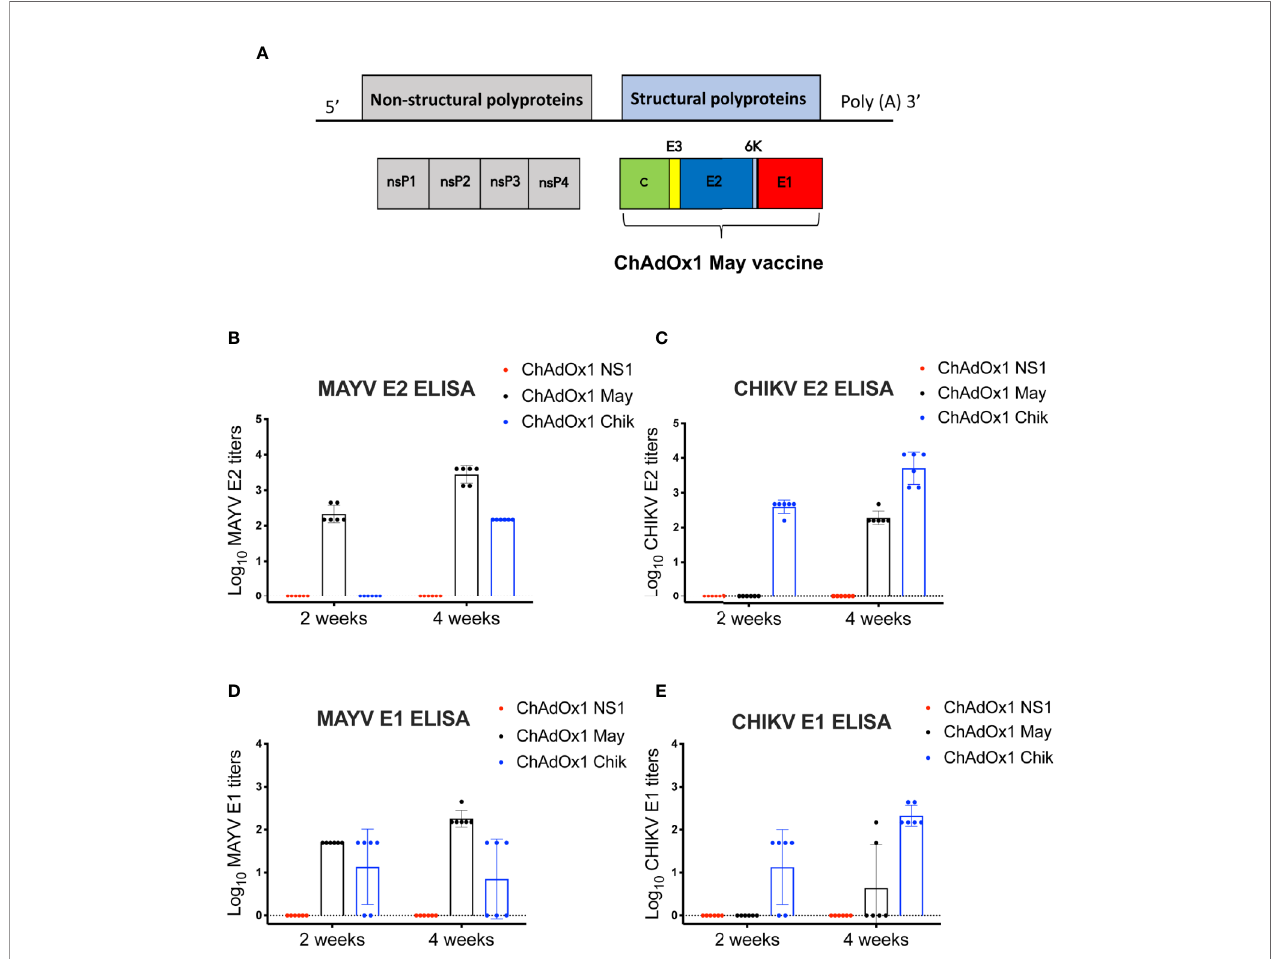
FIGURE 1 | Mayaro virus (MAYV) genome organization, design of ChAdOx1 May vaccine candidate and the humoral responses elicited. (A) . Genome organization of MAYV and generation of ChAdOx1 May vaccine. (B – E) . Humoral IgG responses against chikungunya virus (CHIKV) and MAYV E1,E2 2 and 4 weeks post- immunization measured by ELISA. The reciprocal log ELISA titers were calculated for all groups shown in the fi gure. Lines represent the mean with SD and error bars are